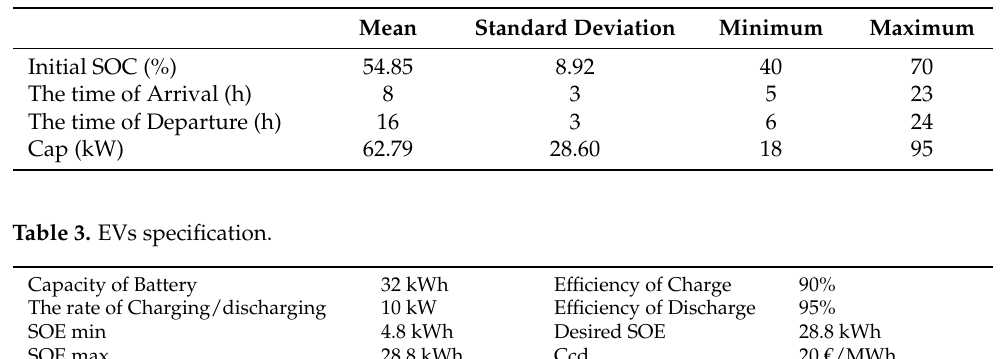
Table 4. The price of energy exchanged between DSO and PLO (cent/kWh).